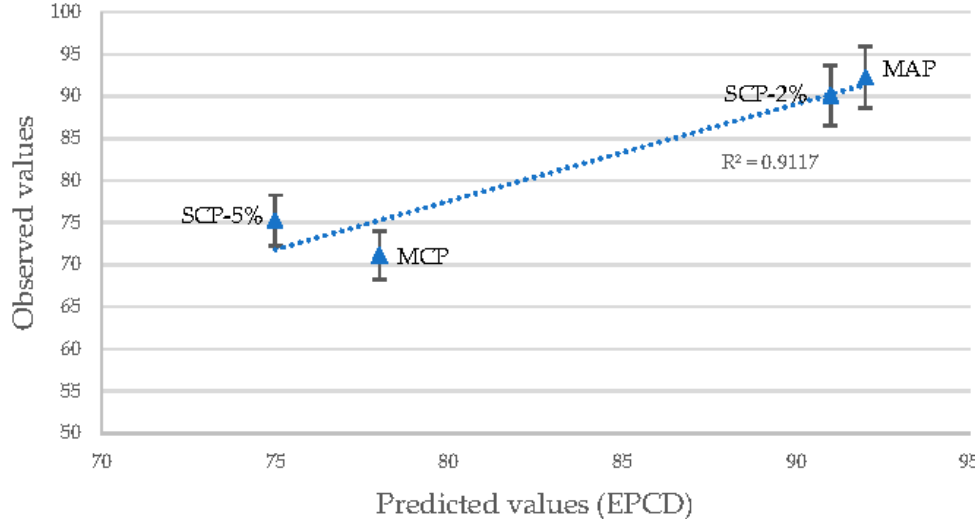
Figure 2. Relationship between the predicted and observed P digestibility values. Figure 2 . Relationship between the predicted and observed P digestibility values.